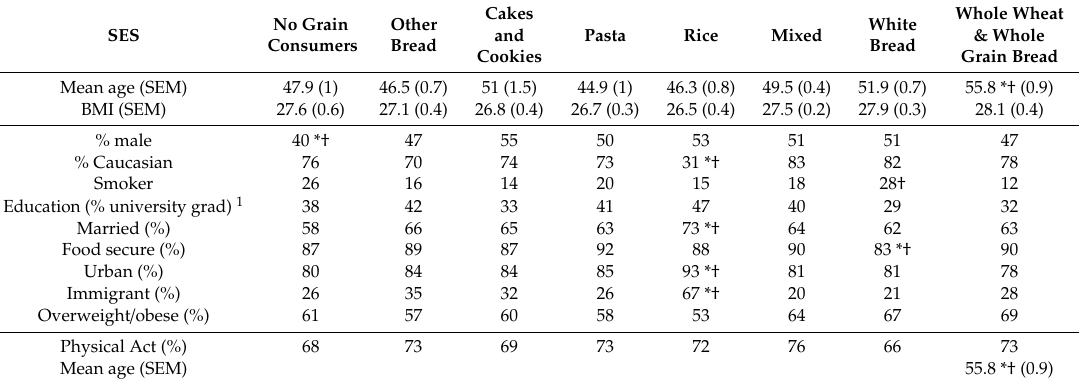
Whole Wheat White & Whole Bread Grain Bread